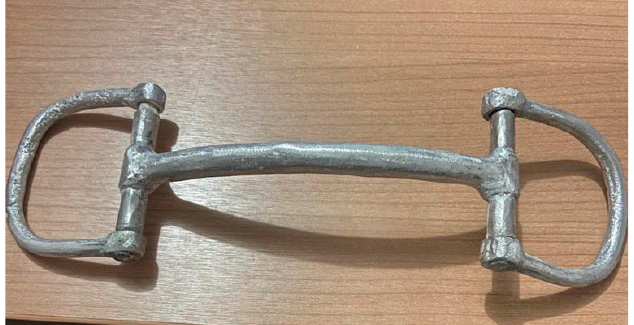
Figure 10. The successful bit prototype selected for trialling during the experimental phase.